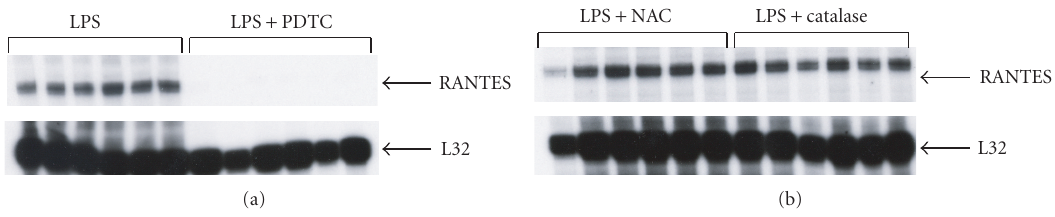
Figure 5: LPS-induced activation of RANTES is abrogated by pharmacological inhibition of NF- κ B but not reactive oxygen species. (a) The NF- κ B inhibitor, PDTC, dramatically suppressed RANTES gene expression in primary diaphragmatic myotubes exposed to LPS. (b) In contrast, two classical antioxidant compounds, N-acetylcysteine (NAC) and catalase, had no measurable e ff ect on RANTES gene expression by diaphragmatic myotubes exposed to LPS under the same conditions. The primary myotube cultures were pretreated with PDTC or the antioxidant compounds for one hour prior to initiating LPS stimulation for 4 hours (1 μ g/mL).